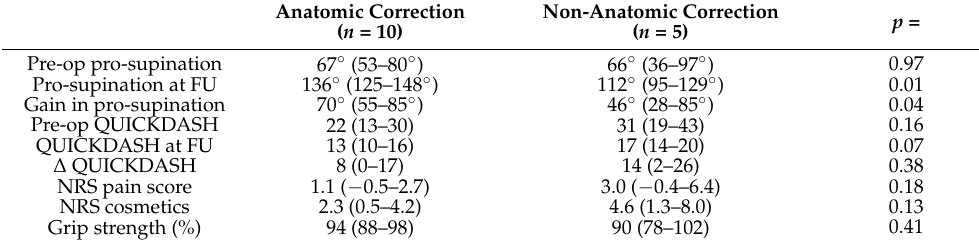
Figure 5. Example of residual malrotation of the radius.